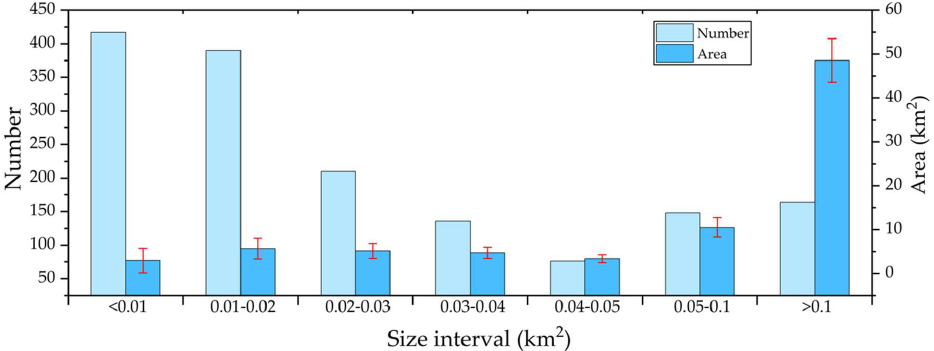
Figure 3. Total number and surface area (km 2 ) of the glacial lakes of various size classes in 2017.